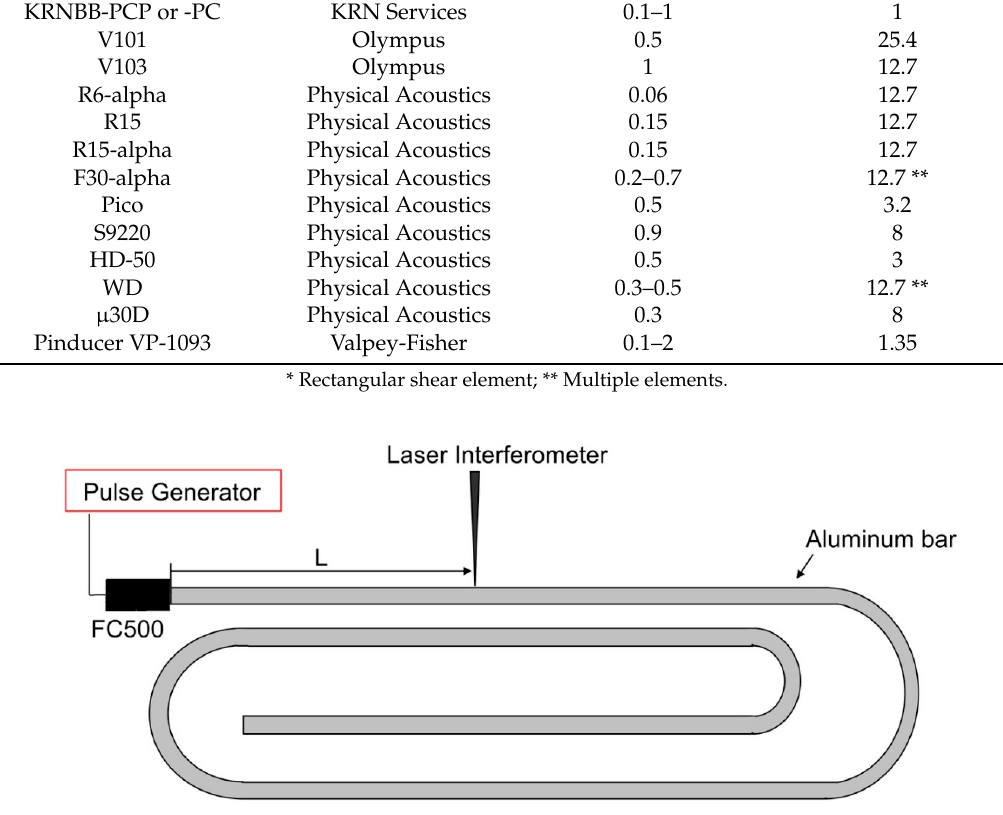
Figure 1. Bar-wave test set-up. An Al6061 bar of 25.4 mm × 6.4 mm × 3660 mm was shaped as shown with an initial straight segment of 700 mm length. FC500 transmitter was glued to its end.